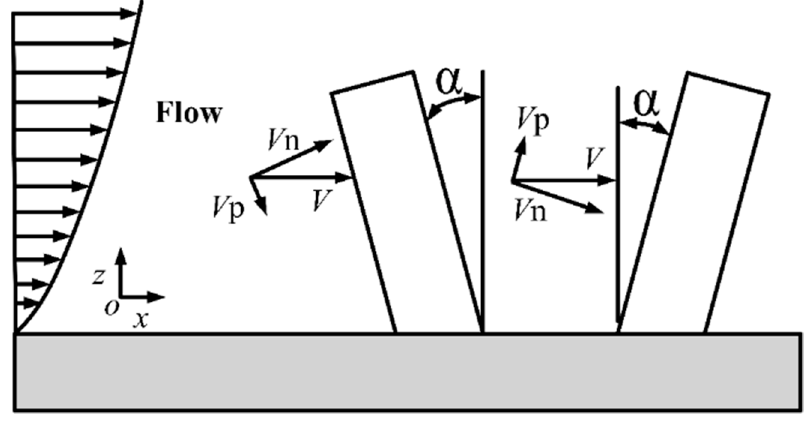
Figure 10. Schematic view of velocity in front of the inclined cylinder.